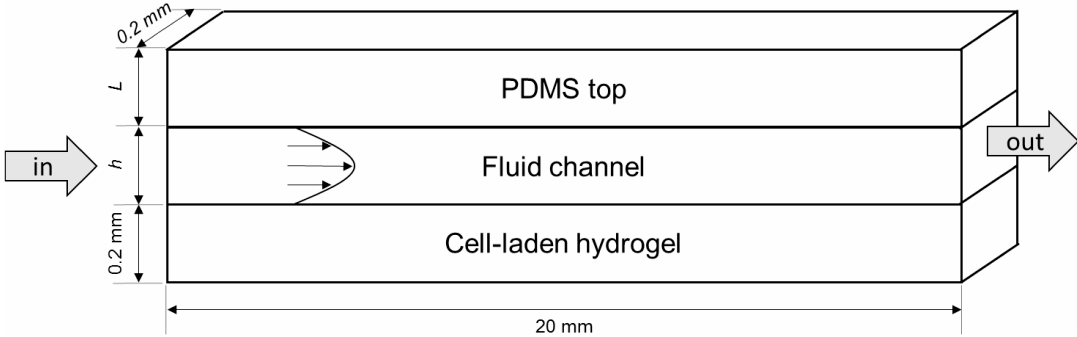
Figure 6. Schematic of the modelled micro- and milli-fluidic systems with a PDMS